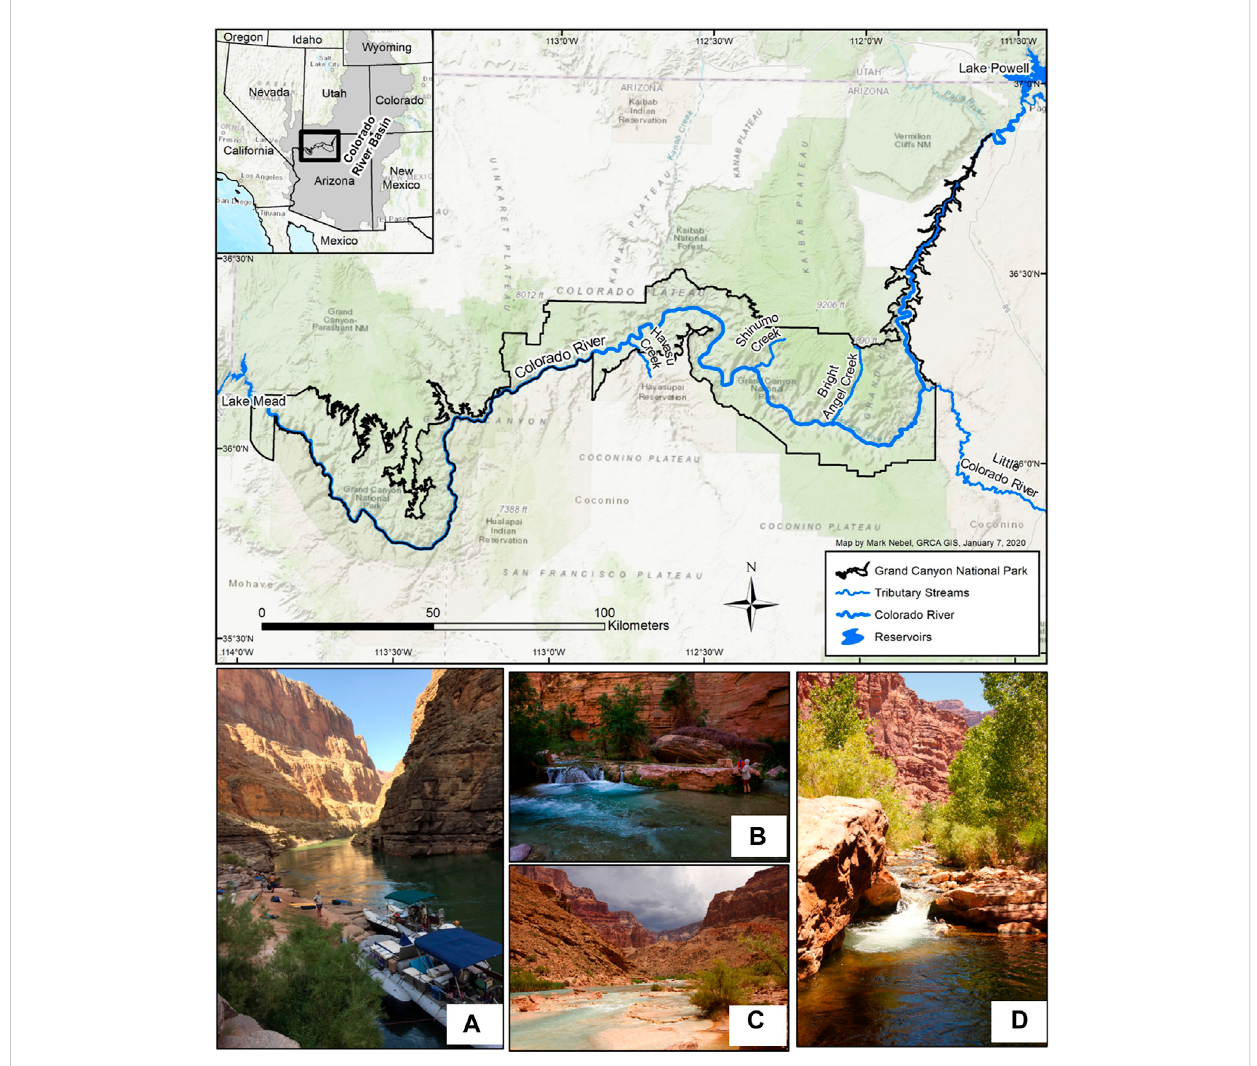
FIGURE 3 Study area map for our case study highlighting humpback chub in the lower Colorado River, Grand Canyon National Park, Arizona, United States. Photos show typical (A) mainstem Colorado Riverhabitat, (B) HavasuCreek, (C) theLittle Colorado River,and (D) ShinumoCreek. Photographs A,C,Dby Brian Healy, National Park Service (NPS), photograph B, Amy Martin,